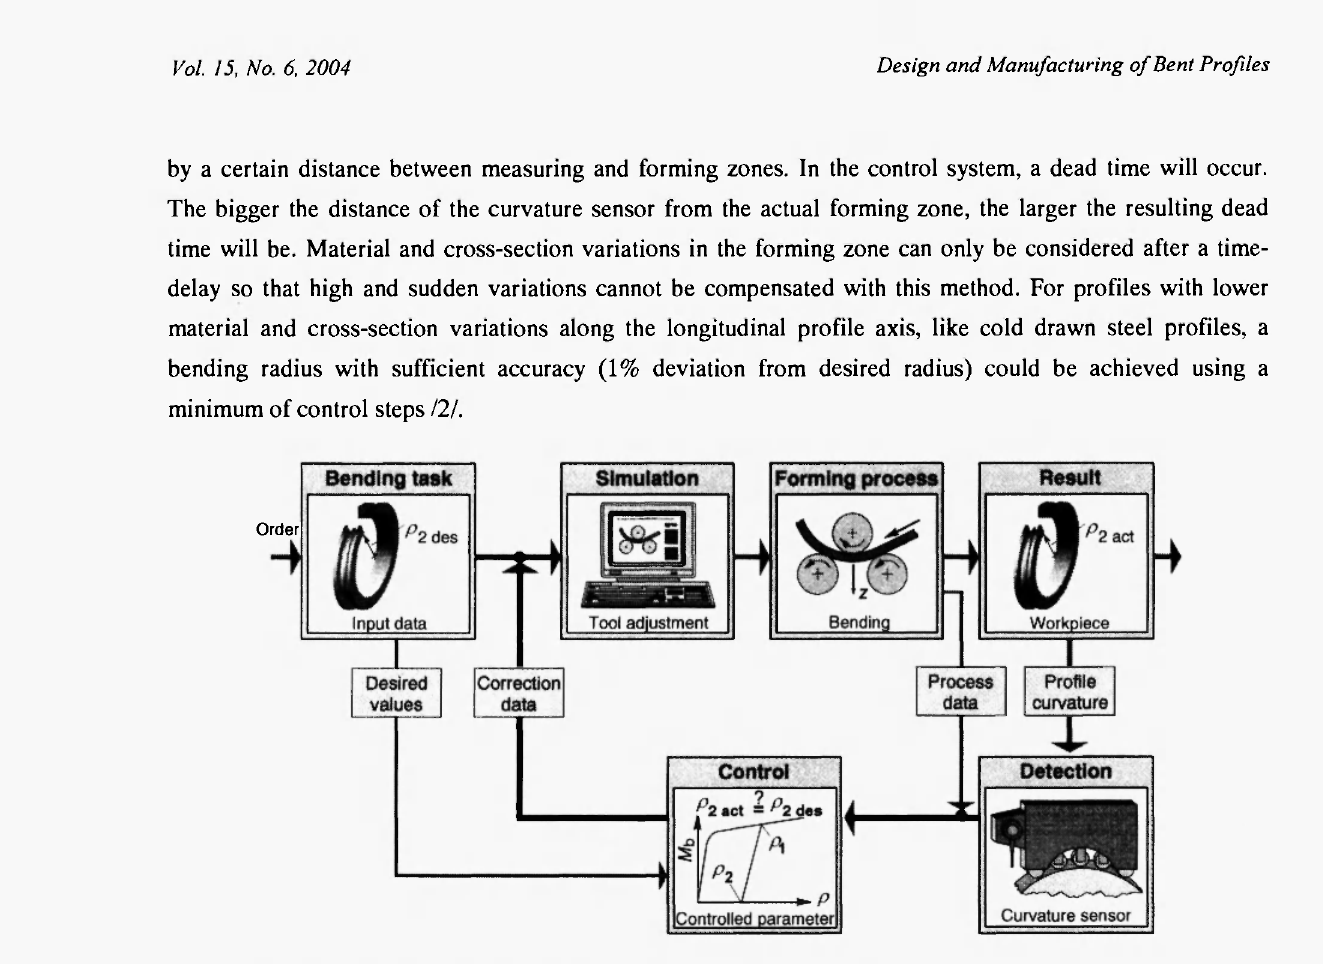
Fig. 4: In-process control system for three-roll-bending of profiles with lower variations of